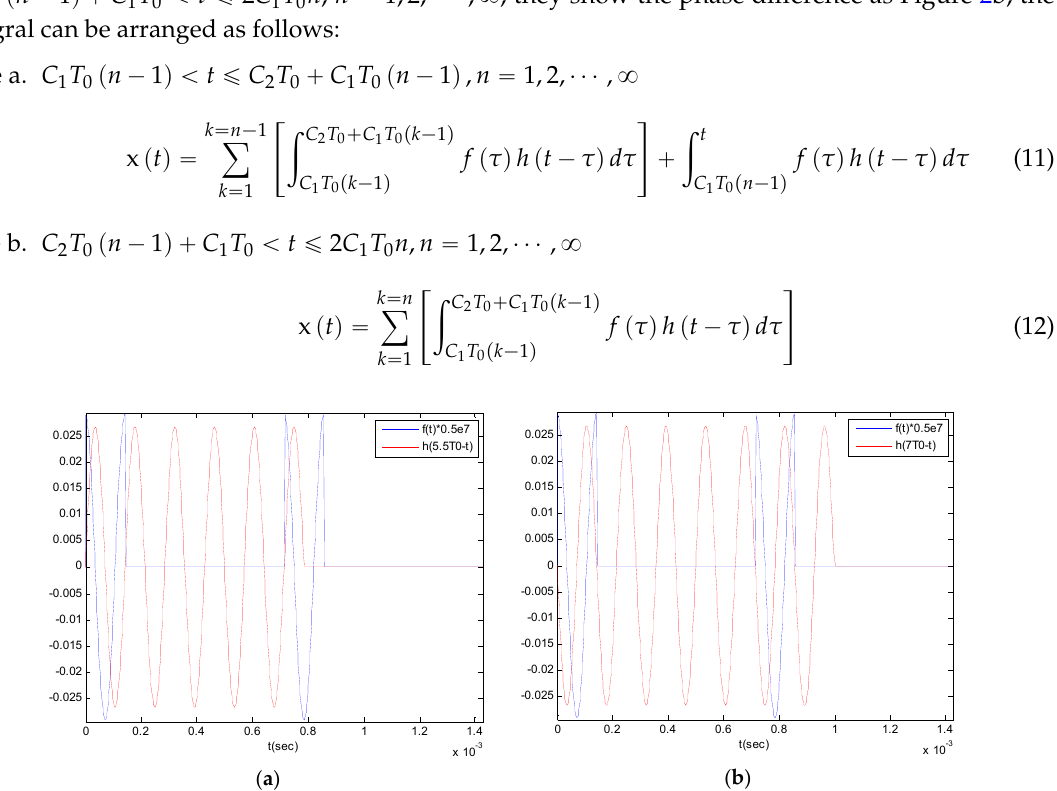
Figure 2. Comparison of the switched control force f p τ q and impulse response h p t ´ τ q : ( a ) case of C 1 T 0 ă t ď C 2 T 0 ; ( b ) case of C 2 T 0 ` C 1 T 0 ă t ď 2 C 1 T 0